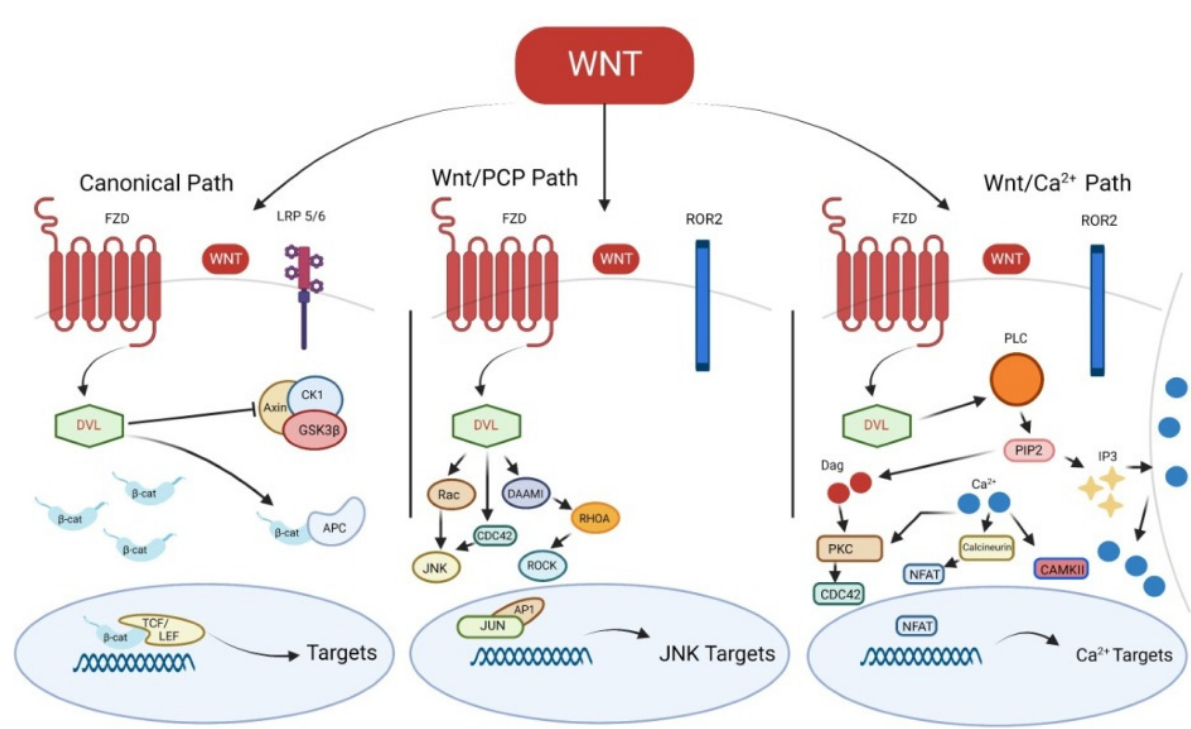
Figure 1. Canonical and non-canonical Wnt signaling pathways. FZD, Frizzled; LRP 5/6, low-density lipoprotein receptor-related protein; DVL, Disheveled; CK1, casein kinase 1 α ; GSK3 β , glycogen synthase kinase 3 β ; β -cat, β -catenin; APC, adenomatous polyposis coli; TCF/LEF, T-cell factor/lymphoid-enhancing factor; Wnt/PCP, Wnt/Planar cell polarity; ROR2, receptor tyrosine kinase-like orphan receptor 2; JNK, c-Jun N-terminal kinase; DAAMI, Disheveled Associated Activator Of Morphogenesis 1; ROCK, Rho-associated kinase; AP-1, the activating protein-1; PLC, phospholipase C γ ; DAG, diacylglycerol; PIP2, phosphatidylinositol 4,5-bisphosphate; IP3, inositol 1,4,5-triphosphate; PKC, protein kinase C; CAMKII, Ca 2+ -calmodulin dependent kinase II; NFAT, nuclear factor of activated T-cells.